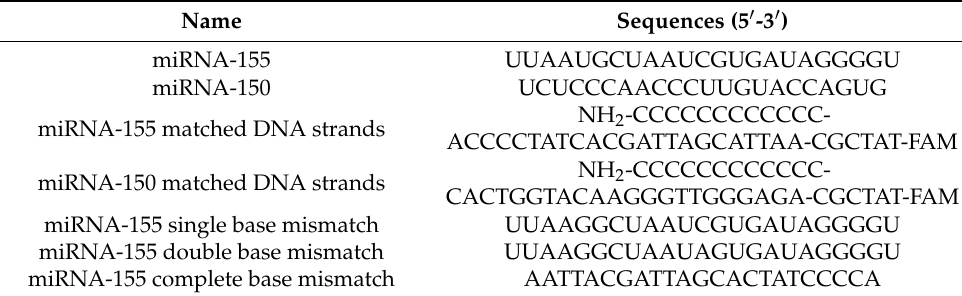
Table 1. Nucleotide sequences of miRNAs and fluorescent probes.